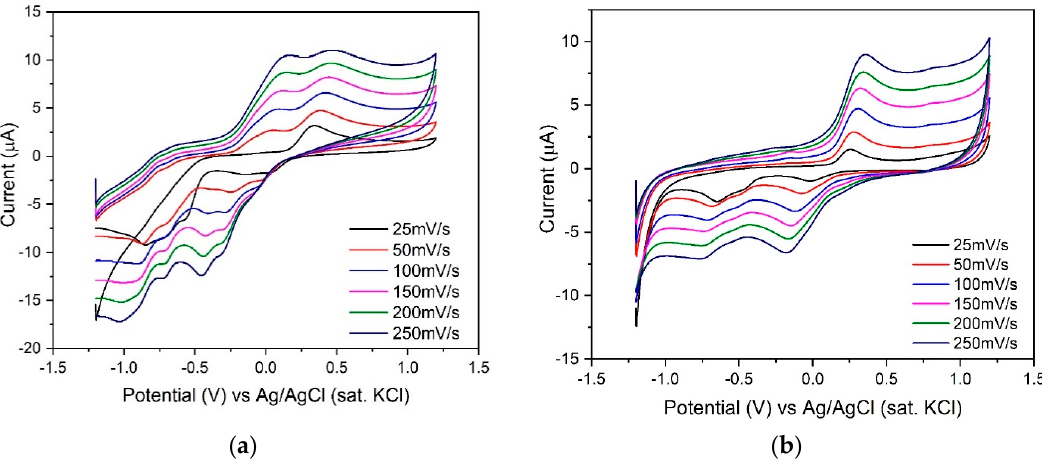
Figure 3. Scan rate has been varied from 25 mV/S to 250 mV/S using [EMIM][BF 4 ]-nafion @GCE in two different analytes. ( a ) CV with different scan rate along with the change of peak current with scan rate (inset) of 2,6 DNT; ( b ) CV with different scan rate along with the change of peak current with scan rate (inset) of ENB.